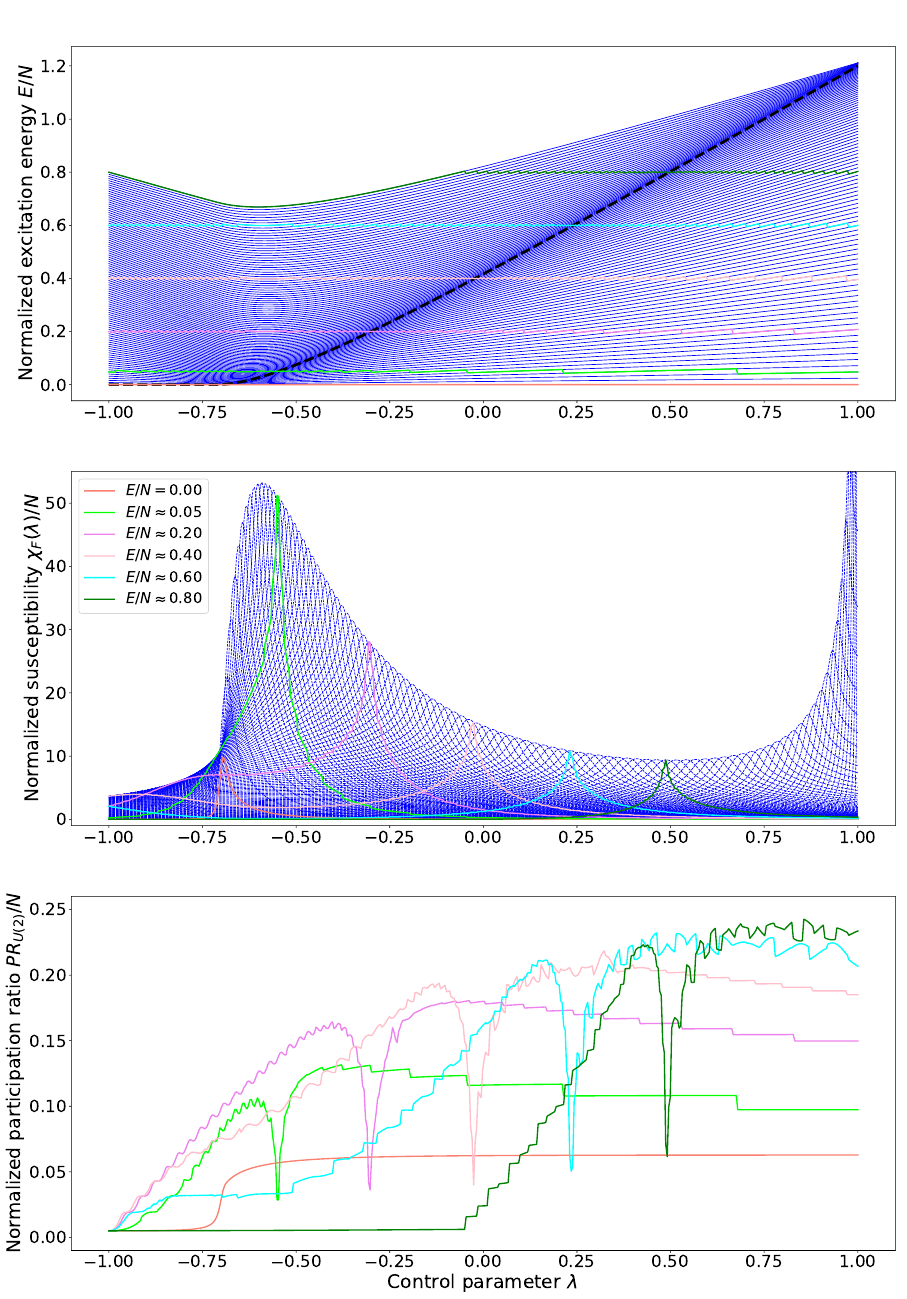
Figure 1: All panels: Results for a 2DVM Hamiltonian (10) with ξ = 0.6 and N = 200. For the sake of clarity, the ground state and states with normalized ex- citation energies closer to 0.05,0.2,0.4,0.6, and 0.8 have been highlighted using dif- ferent colors (orange, light green, purple, pink, cyan, and dark green, respectively). The rest are plotted with blue dashed lines. All quantities are plotted versus the con- trol parameter λ . Upper panel: Normalized excitation energy of (cid:96) = 0 eigenstates of the model Hamiltonian (10). Middle panel: Normalized QFS (9). Lower panel: Normalized PR in the U ( 2 ) basis (3) for the set of selected states indicated